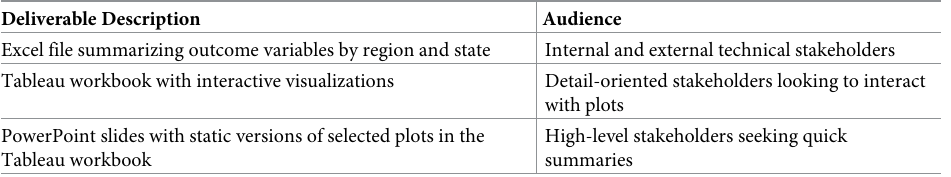
Table 1. Weekly deliverables for key stakeholders.